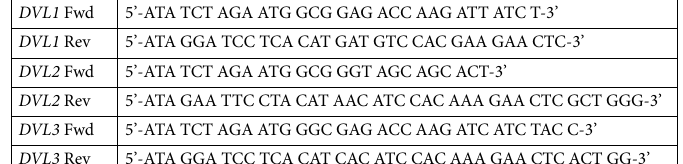
Table 1. Primer sequences for cloning DVLs into the pUltra backbone.